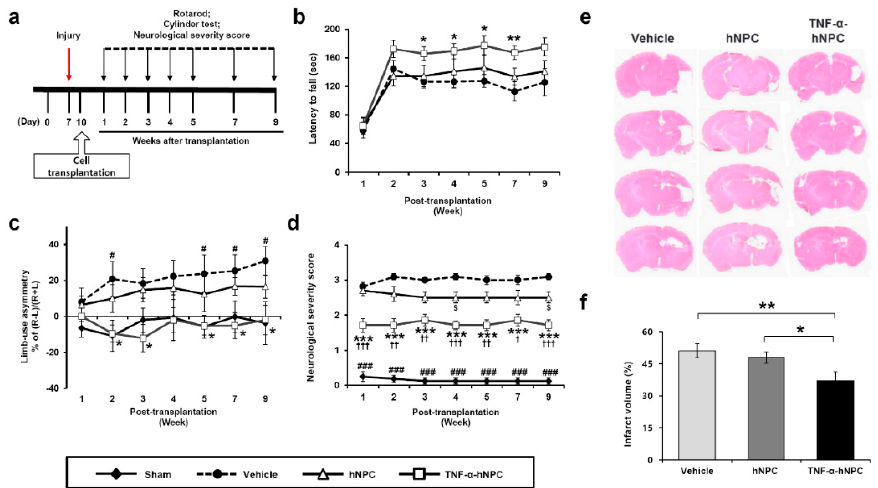
Figure 3. TNF- α -pretreated hNPCs transplantation attenuated the cerebral infarct volume and facilitated functional recovery after HI brain injury. ( a ) Experimental design for behavioral tests. Behavioral tests were performed at 1–5, 7, and 9 weeks post-transplant. Functional recovery after HI brain injury was evaluated using ( b ) a rotarod test, ( c ) a cylinder test, and ( d ) the neurological severity score. ( b – d ) * p < 0.05, ** p < 0.01, and *** p < 0.001, for comparisons between TNF- α -hNPC- and vehicle-treated groups; # p < 0.05 and ### p < 0.001, for comparisons between sham control and vehicle-treated groups; $ p < 0.05, for comparisons between hNPC- and vehicle-treated groups; † p < 0.05, †† p < 0.01, and ††† p < 0.001, for comparisons between TNF- α -hNPC- and hNPC-treated groups. ( e ) Representative image of coronal brain sections (H&E staining) from mice treated with vehicle, hNPCs, and TNF- α -hNPCs at 9 weeks after transplantation. ( f ) Infarct volume was significantly attenuated in the TNF- α -hNPC group compared with the vehicle and hNPC groups (n = 7 per group). * p < 0.05, ** p < 0.01. Data are presented as the mean ± SEM.